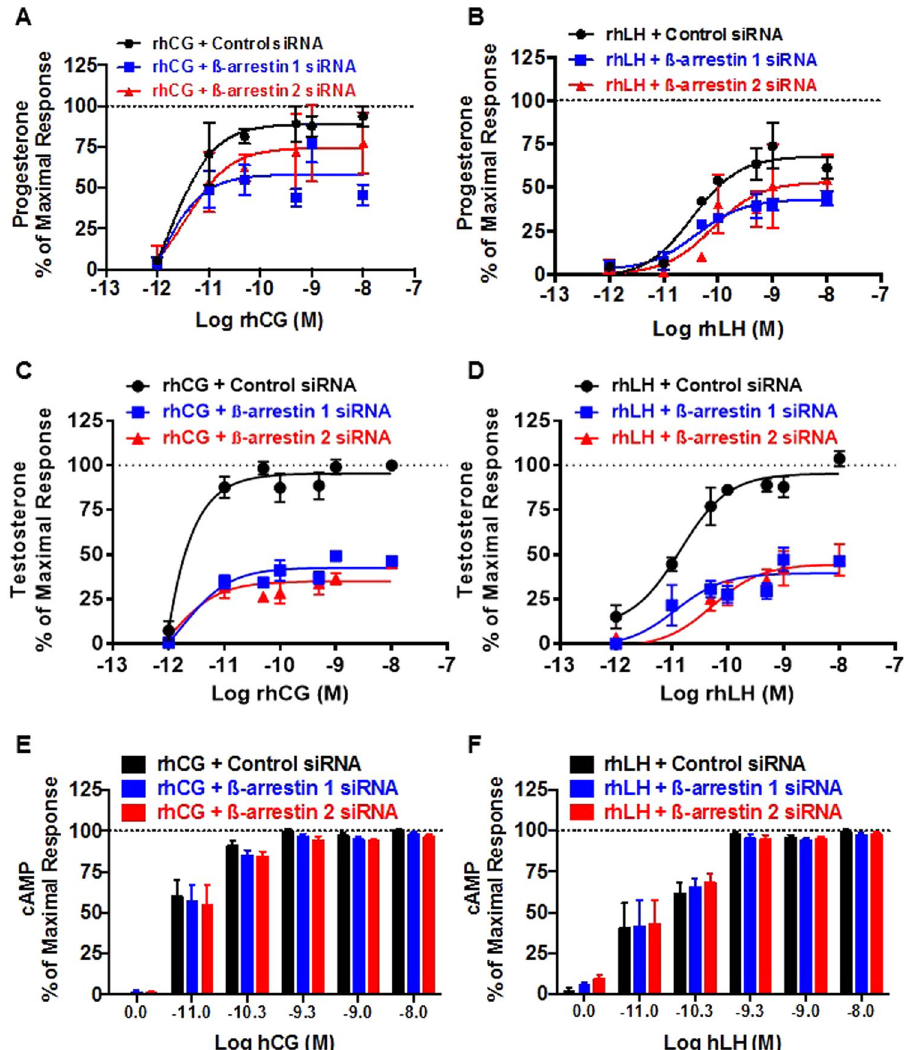
Figure 4. Implication of β -arrestins in LH/CGR-promoted steroid production in mLTC-1 cells. mLTC-1 cells were transiently transfected with either control, β -arrestin 1 or β -arrestin 2 siRNAs. Then, cells were stimulated 3 hours with increasing doses of rhCG ( A , C and E ) and rhLH ( B , D and F ) before progesterone ( A and B ), testosterone ( C and D ) and cAMP ( E and F ) productions were measured. The maximal rhCG-mediated responses obtained at 10 nM with control siRNA was taken as 100%. Data are means ± SEM of 3 independent experiments performed in duplicate.